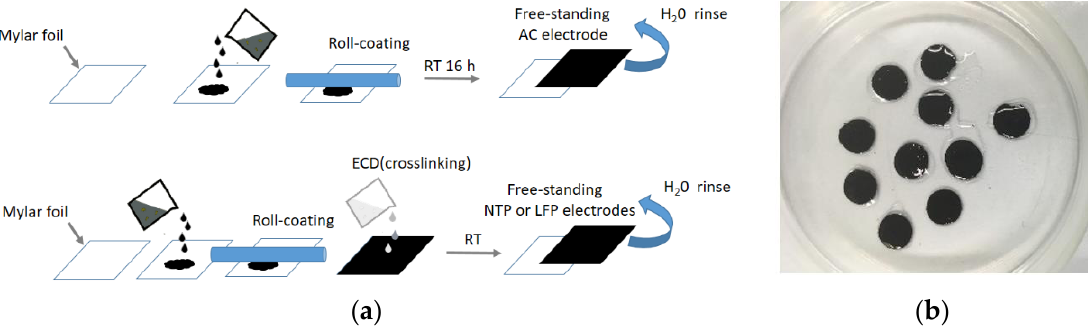
Figure 3 . ( a ) Self standing electrode preparation scheme and ( b ) self-standing electrodes soaked with EDC solution. EDC